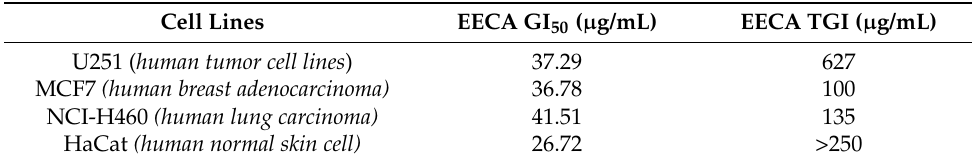
Table 2. GI50 and TGI values for extracts of essential oil of C. articulatus .